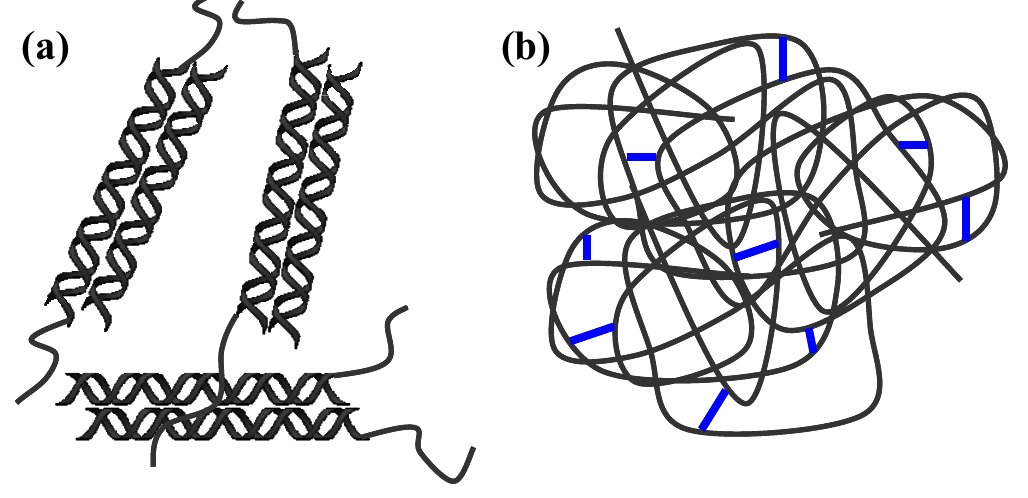
Figure 1. Schematic representation of: (a) physical gel of Gellan; (b) chemical gels of